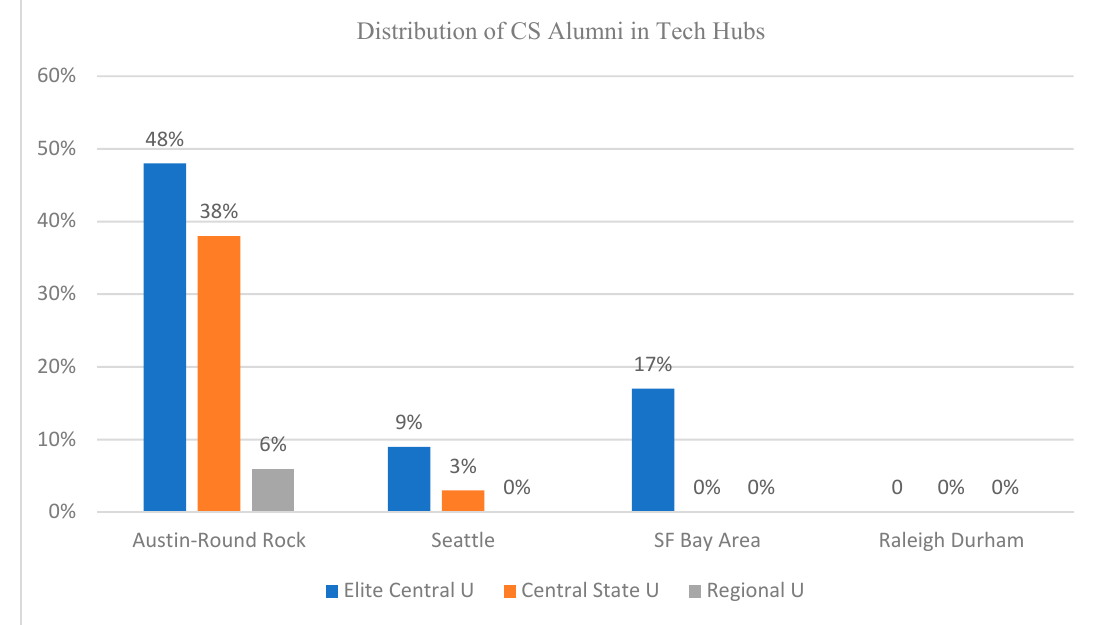
Figure 1. Distribution of CS Alumni in Tech Hubs.